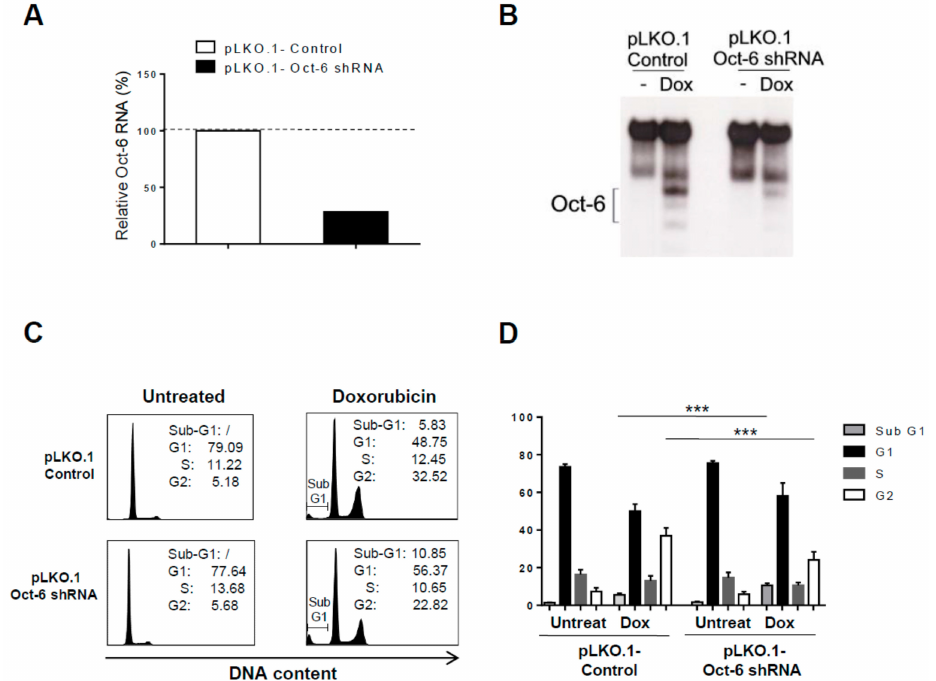
Figure 3. Knockdown of Oct-6 a ff ects cellular response to genotoxic stress: e ff ect on cell cycle arrest. ( A ) The total mRNA was obtained from untreated or 24 h Dox-treated H460 cells infected with lentivirus pLKO-shRNA-Oct-6 or non-target shRNA, and analyzed for Oct-6 mRNA expression by real-time PCR. The data, expressed as fold change units, were normalized with GAPDH, and were referred to the cells infected with non-target shRNA, considered as a calibrator, and represent the mean of three experiments (* p < 0.05; left panel). ( B ) EMSA was performed, as described above, in the presence of nuclear extracts obtained from pLKO-shRNA-Oct-6 or non-target shRNA infected H460 cells unstimulated (-), or treated with Dox for 24 h (right panel). ( C ) Control or Oct-6 silenced H460 cells, left untreated (-) or treated with Dox 0.5 µ M for 48 h, were fixed and stained with propidium iodide (PI) to analyze the cell distribution among the di ff erent cell cycle phases. ( D ) Histograms of the di ff erent cell-cycle phases represent the mean of six independent experiments. Error bars indicate standard error of the mean (SEM; ** p < 0.01; paired t